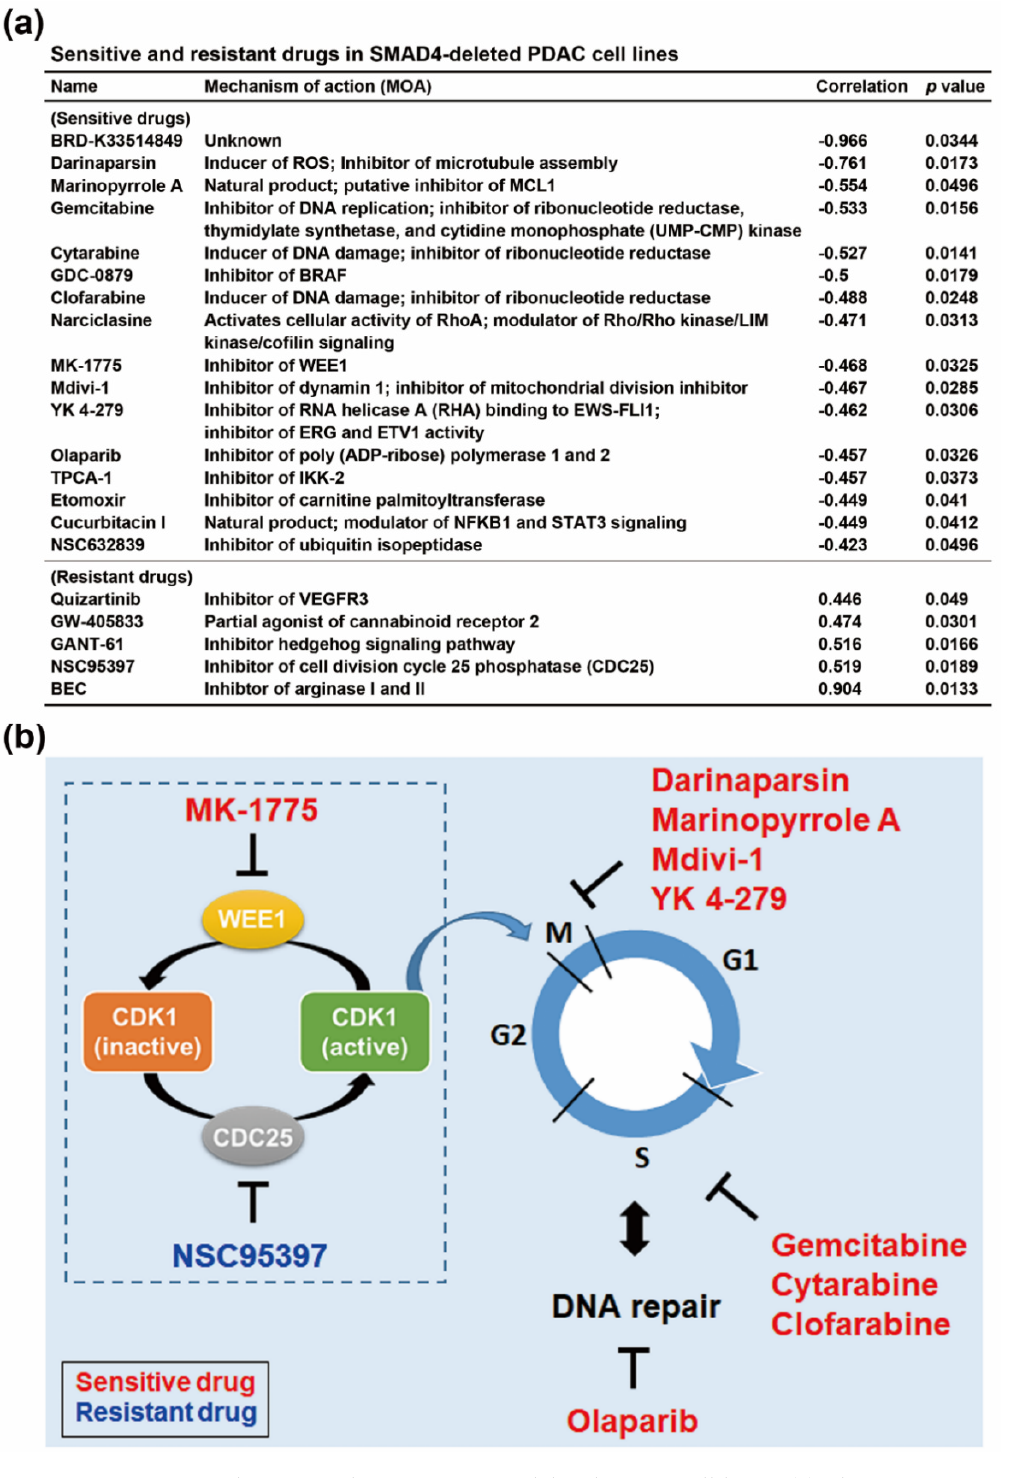
Figure 3. Sensitive and resistant drugs in SMAD4-deleted PDAC cell lines. ( a ) Chemosensitivity profiles, correlated with SMAD4 copy numbers in PDAC cell lines, were obtained from the CTRP database via an online tool, the CellMinerCDB; ( b ) The e ff ect of drugs on cell cycle